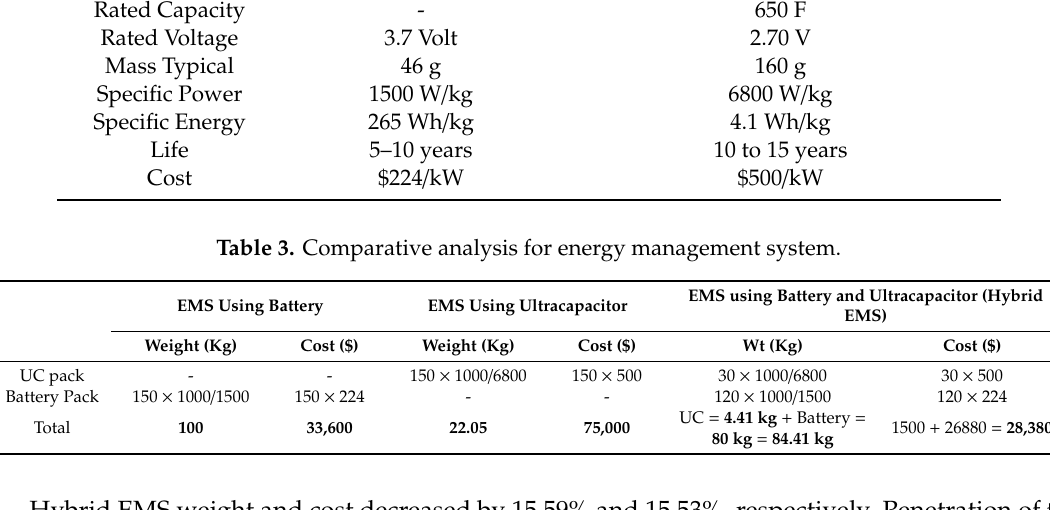
Table 2. Specifications of the battery and ultracapacitor.